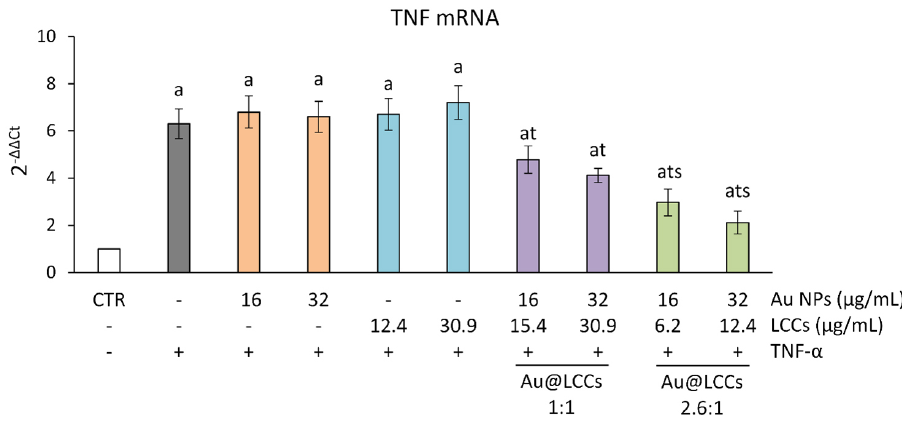
Figure 9. TNF gene expression in differentiated Caco-2 cells. The Caco-2 monolayers were pretreated or not with Au NPs (range: 16–32 µg/mL), LCCs (range: 6.2–30.9 µg/mL) or the